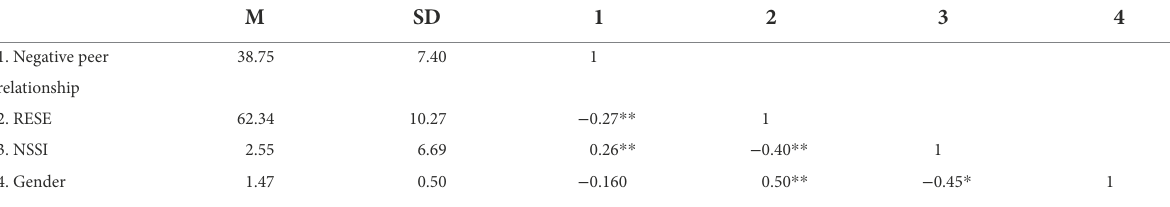
TABLE 1 Correlation analysis between variables.